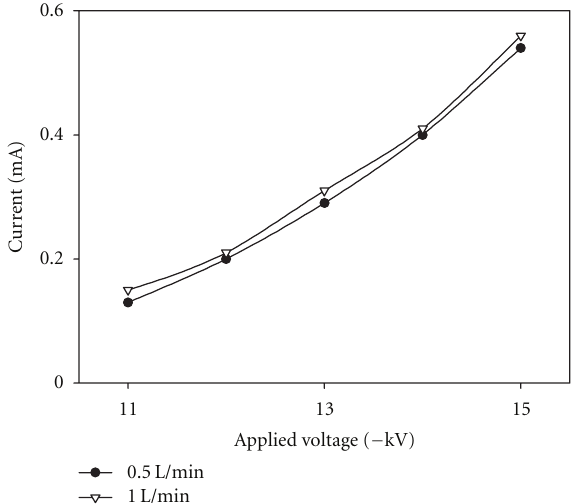
Figure 4: Voltage-current characteristics in the wet ESP.